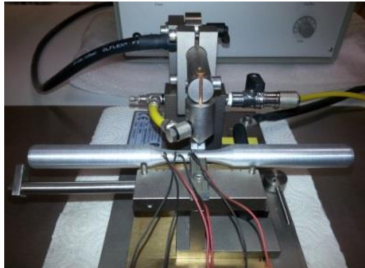
Figure 3. Example specimen during welding of the thermocouple with a lateral surface.